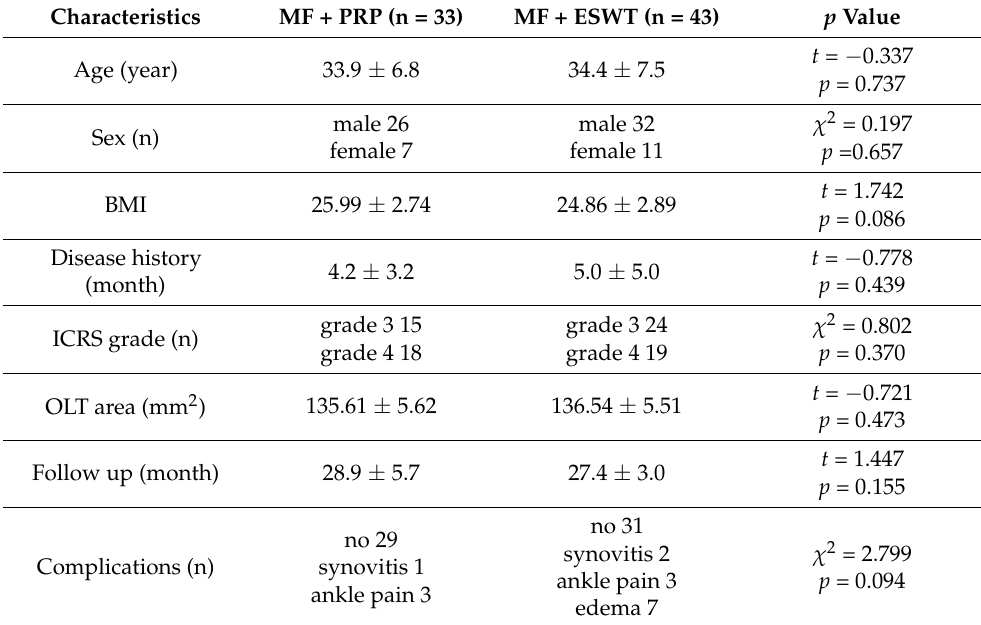
Table 1. Basic characteristics of the OLT patients in the MF + PRP and MF + ESWT groups.